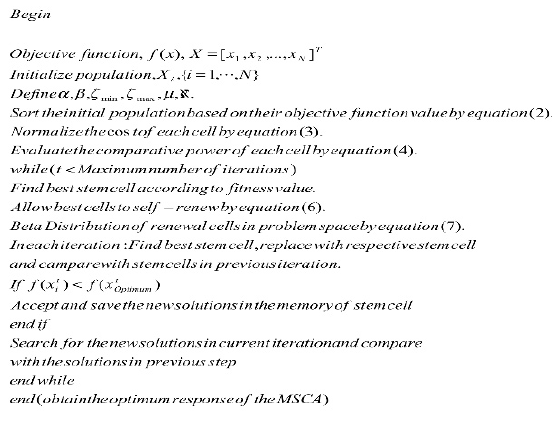
randomly. Figure 1 shows an example of self-renewal characteristics of stem cells until reaching to the optimum cell